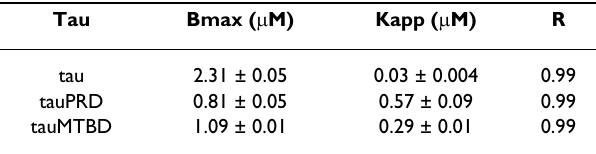
Data were taken from Figure 6, and conditions were the same as for Table 1, except that the reaction of F-actin with tauPRD was monitored by solid phase